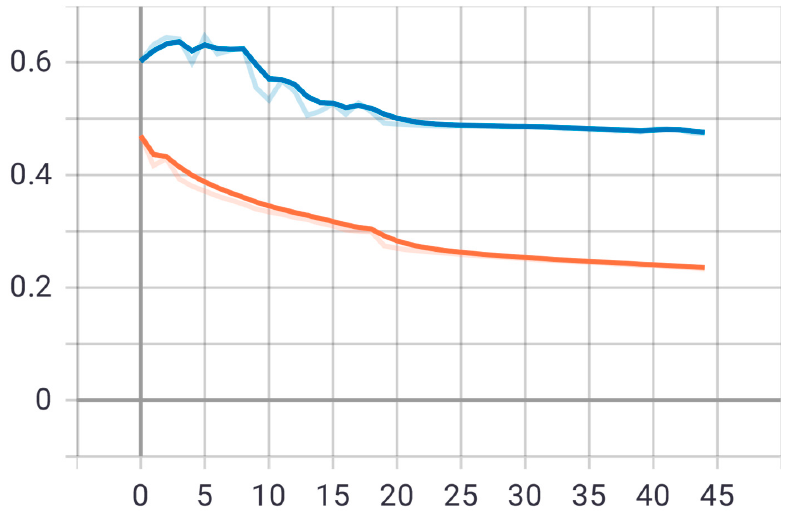
Figure 15. Accuracy (red line) and validation (blue line) loss curves of the second model over 45 epochs.